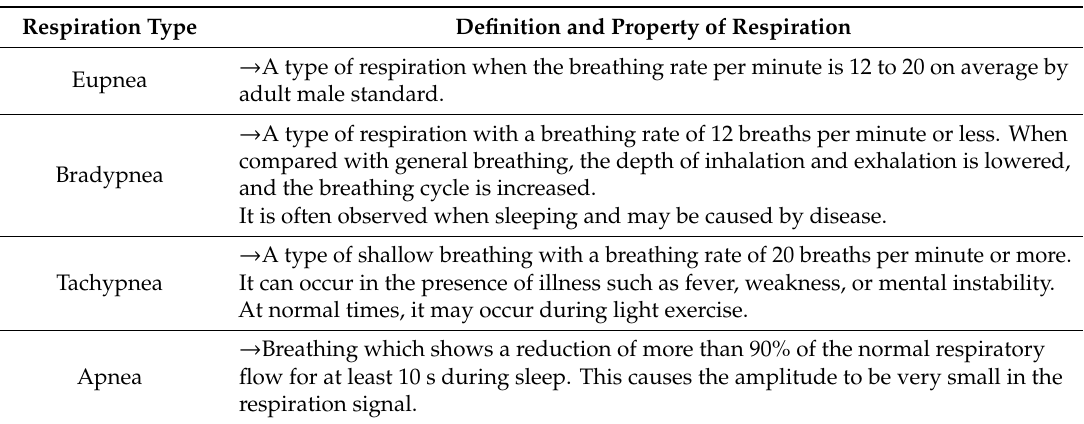
Table 1. Types of respiration defined by using breath rate per a minute in medical field. Respiration